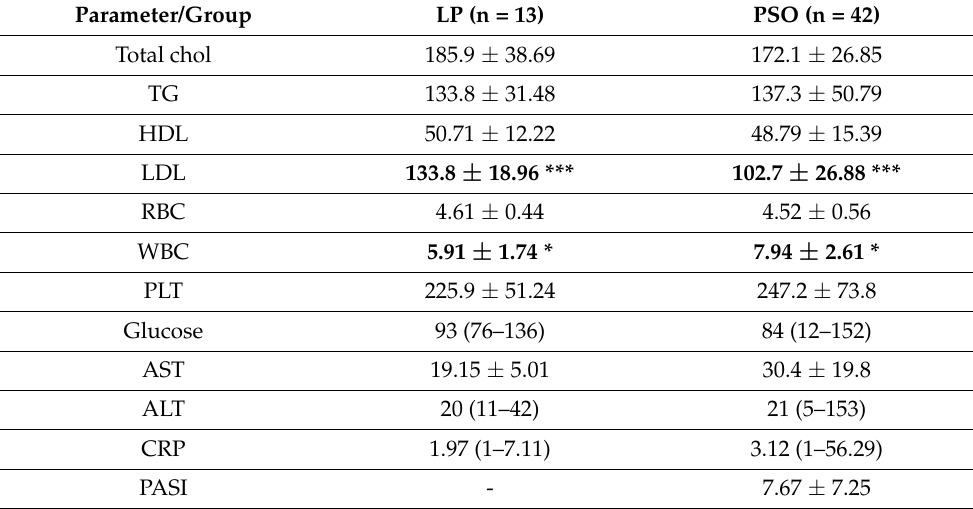
Table 2. Biochemical analysis of the studied groups.